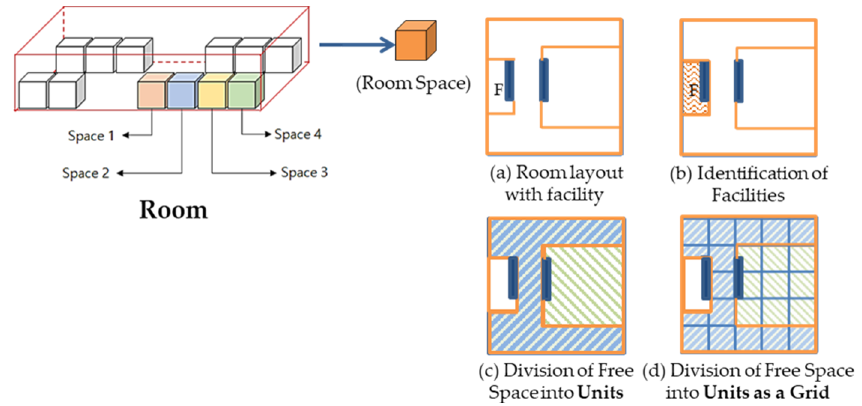
Figure 3. Subdivision of a room into smaller units.